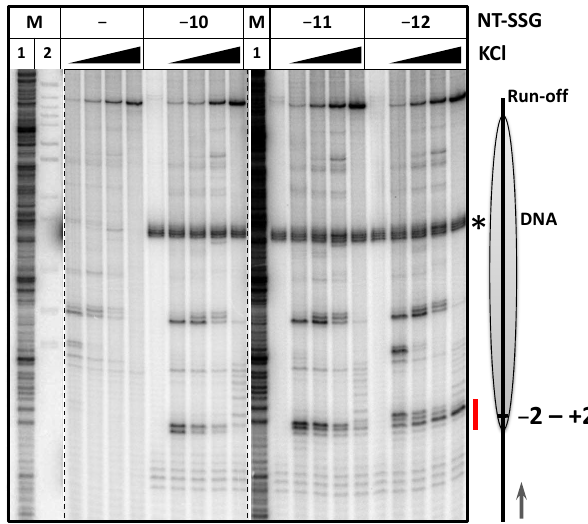
Figure 3. Single strand gaps at positions −10, −11 and −12 induce arrest of RNAP at the nucleosome entry site. Transcription of 603 nucleosomes containing single NT-SSGs at the positions −12, −11 or −10 by E. coli RNAP for 5 min at 40, 150, 300 or 1000 mM KCl. Analysis of pulse-labeled RNA by denaturing PAGE. M1—RNA marker (see Methods). M2—pBR322 MspI digest. The radioactively labeled fragment of the gap-containing non-template DNA strand (103 nucleotides in length) is shown by the asterisk. The region of RNAP arrest near position +1 in presence of NT-SSGs is shown by the red line. Other designations as in Figure 2A.